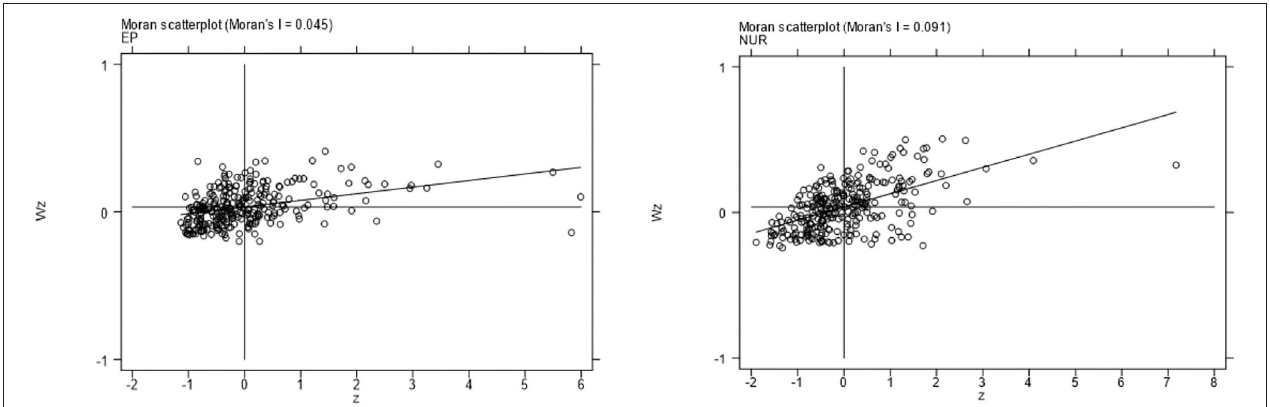
FIGURE 1 | Scatter plot of the Moran index of China’s environmental pollution and new urbanization in 2013.